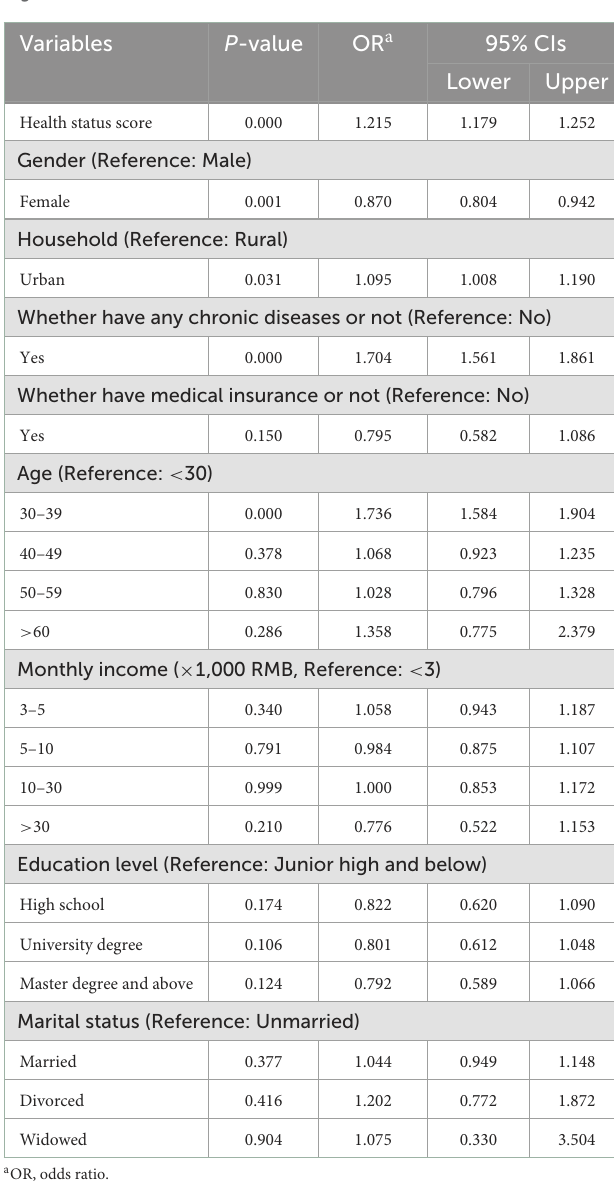
TABLE 2 Association of risk factors of Internet-based healthcare service usage provided by primary health institutions from multivariable logistic regression